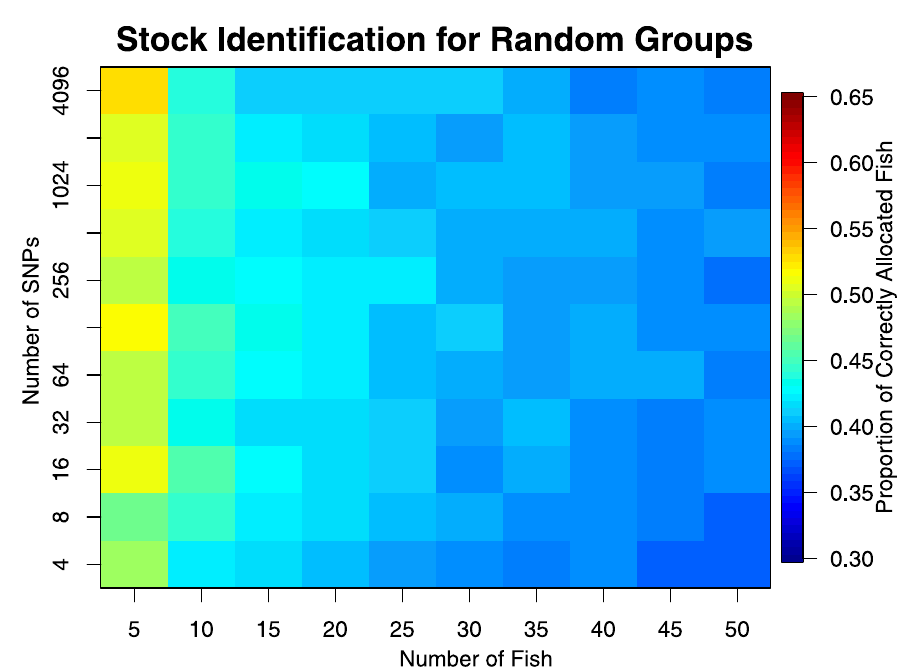
Fig 6. Results from randomising the location information from the 3 Western Pacific regions for stock identification. If stock identification is successful, then all values should be 1/K = 1/3. Higher values indicate that groups can be found, even though they are not present. Colour scale chosen to match Fig